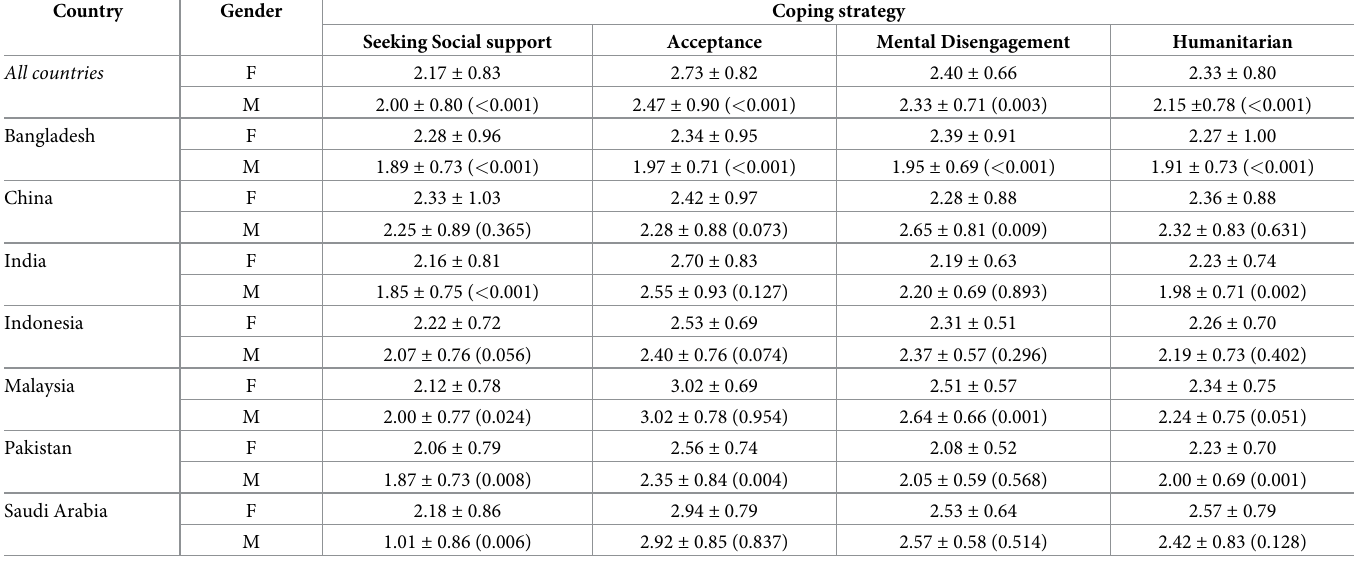
Table 5. Coping strategies used between male and female students by